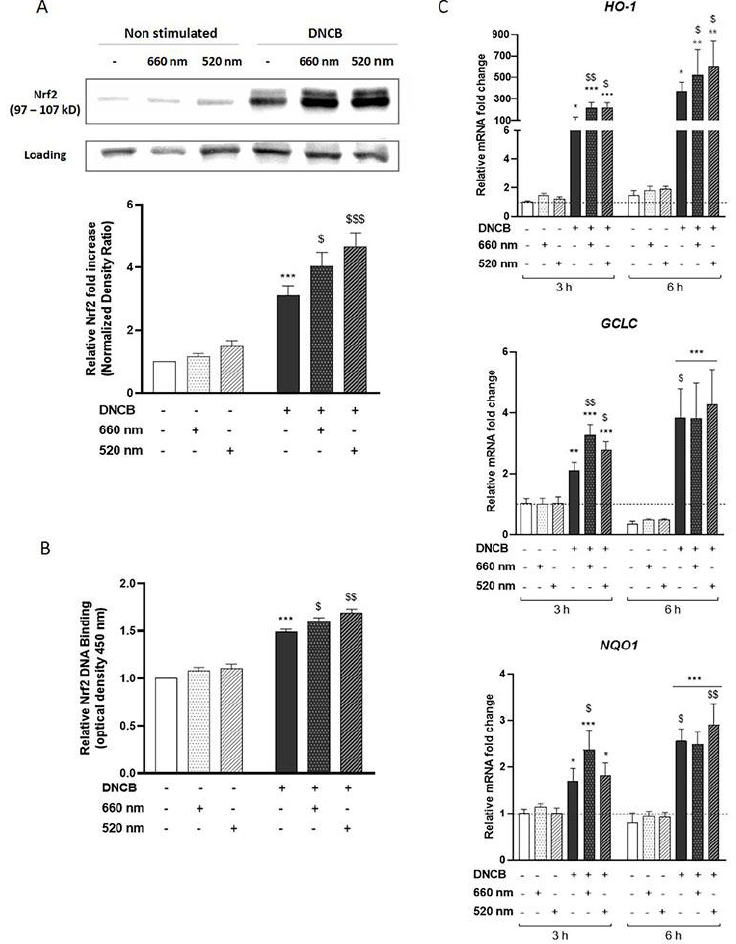
Figure 2. PBM enhances Nrf2-pathway activation in DNCB-stimulated KCs. KCs were treated with vehicle (DMSO 0.1%) or DNCB (25 µM) and illuminated with either wavelength: 660 nm (red light) free blot. ( B ) ELISA-based measurement of DNA-binding activity for activated Nrf2 in the nuclear extract, 4 h after KCs treatment. ( C ) Nrf2 target antioxidant gene expression: HO-1 , GCLC , and